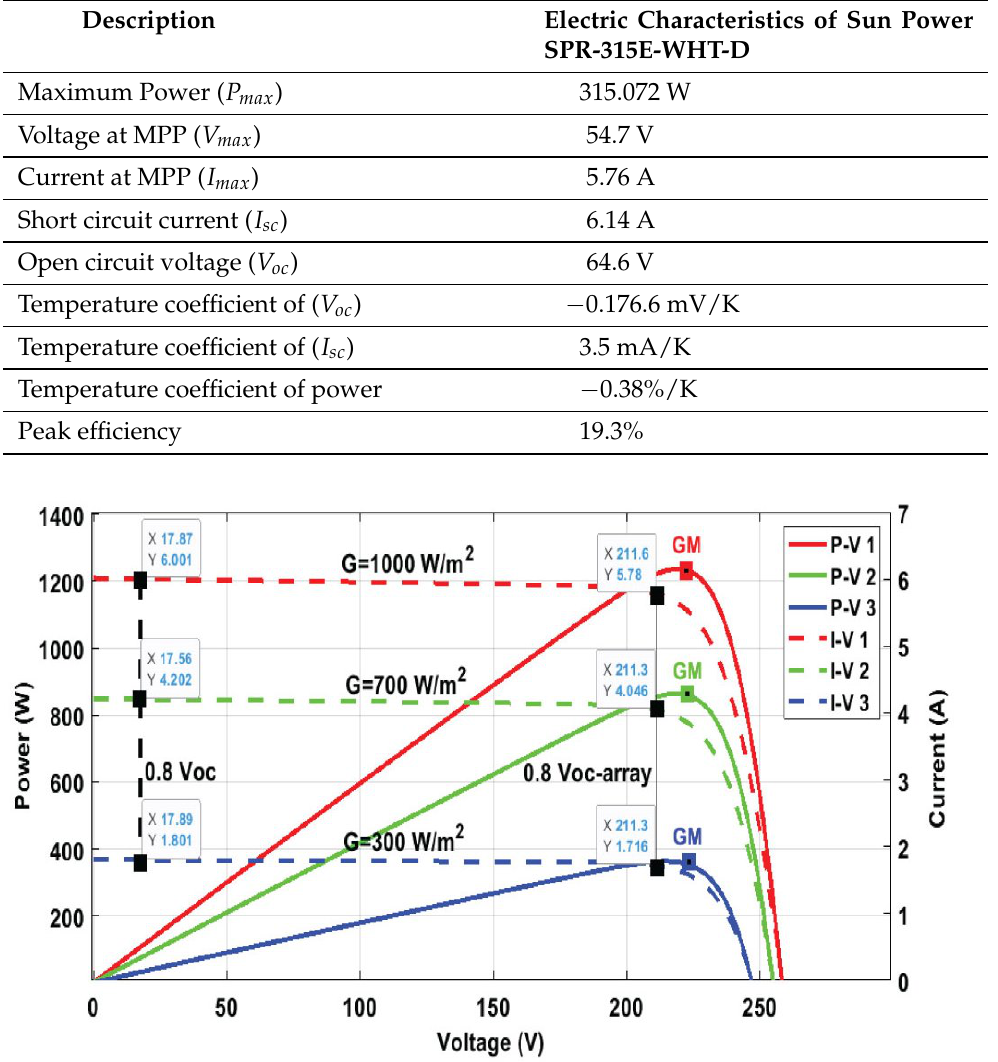
Figure 7. I-V and P-V curves of the PV